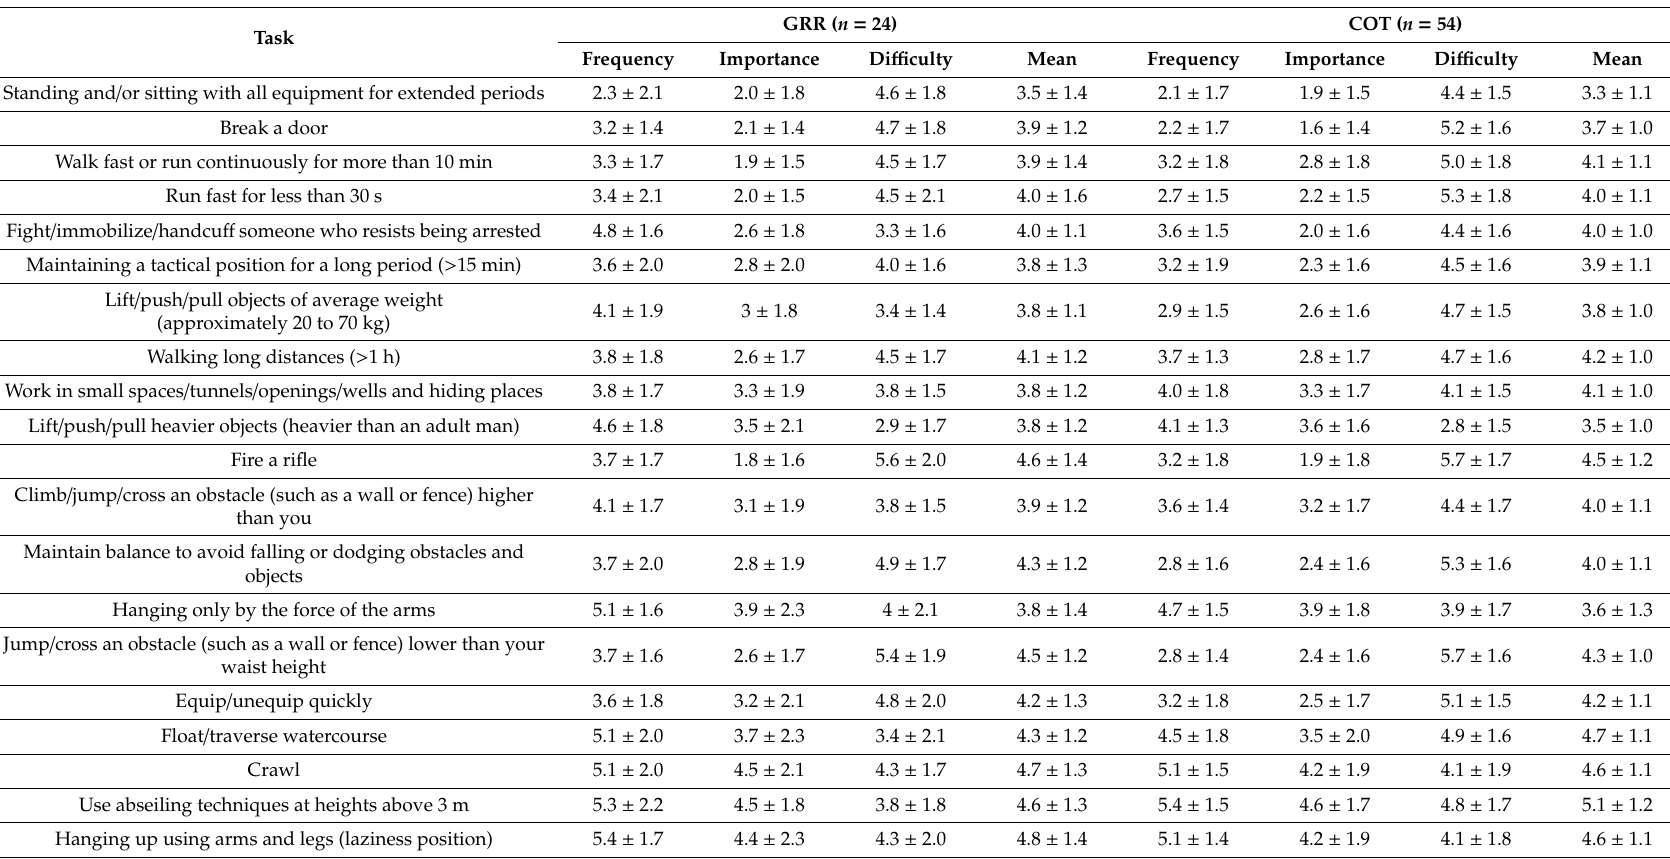
Table 3. Classification of tasks by frequency, importance, di ffi culty, and mean of frequency and di ffi culty. GRR ( n = 24) COT ( n = 54) Task Frequency Importance Di ffi culty Mean Frequency Importance Di ffi culty